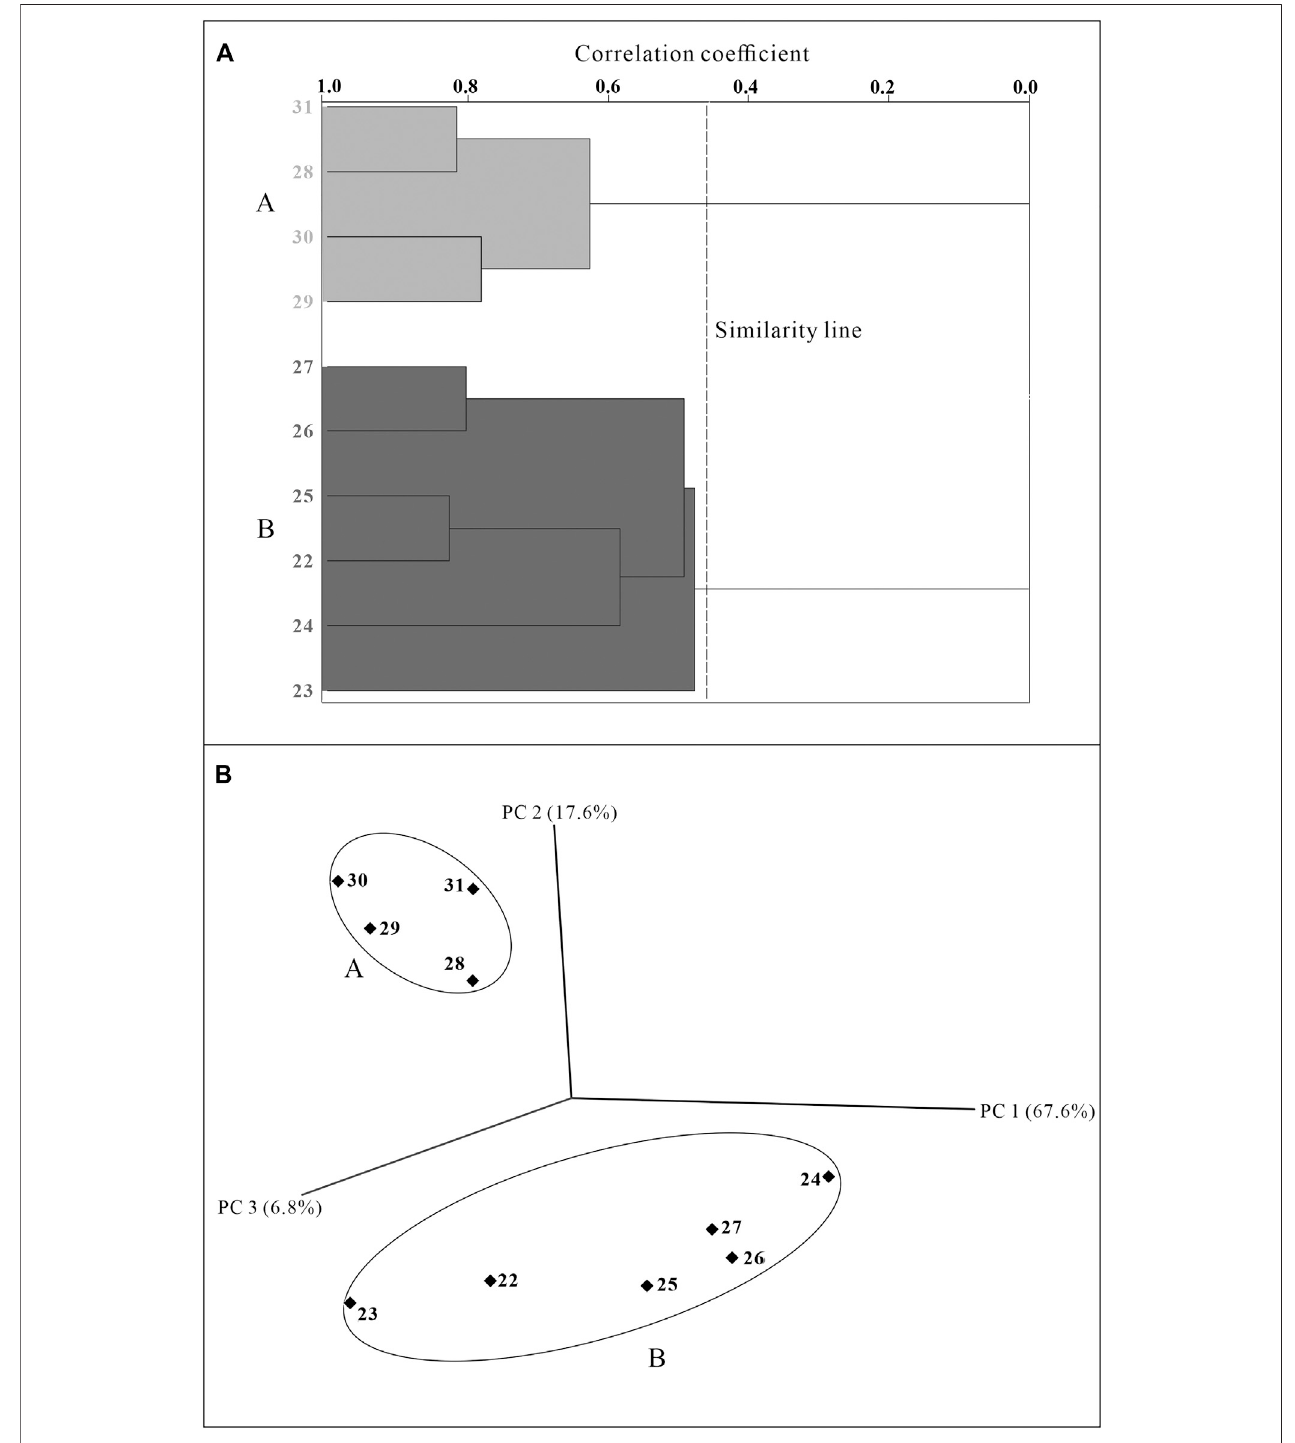
FIGURE6| Chemometric analysisofoilgeneticfamiliesfor theWushiSag oftheBeibu GulfBasinbasedon (A) hierarchical clusteranalysis(HCA) and (B) principal component analysis (PCA). The fi rst three components of PCA, including PC1, PC2, and PC3, account for 92% of the total variance in the original dataset.